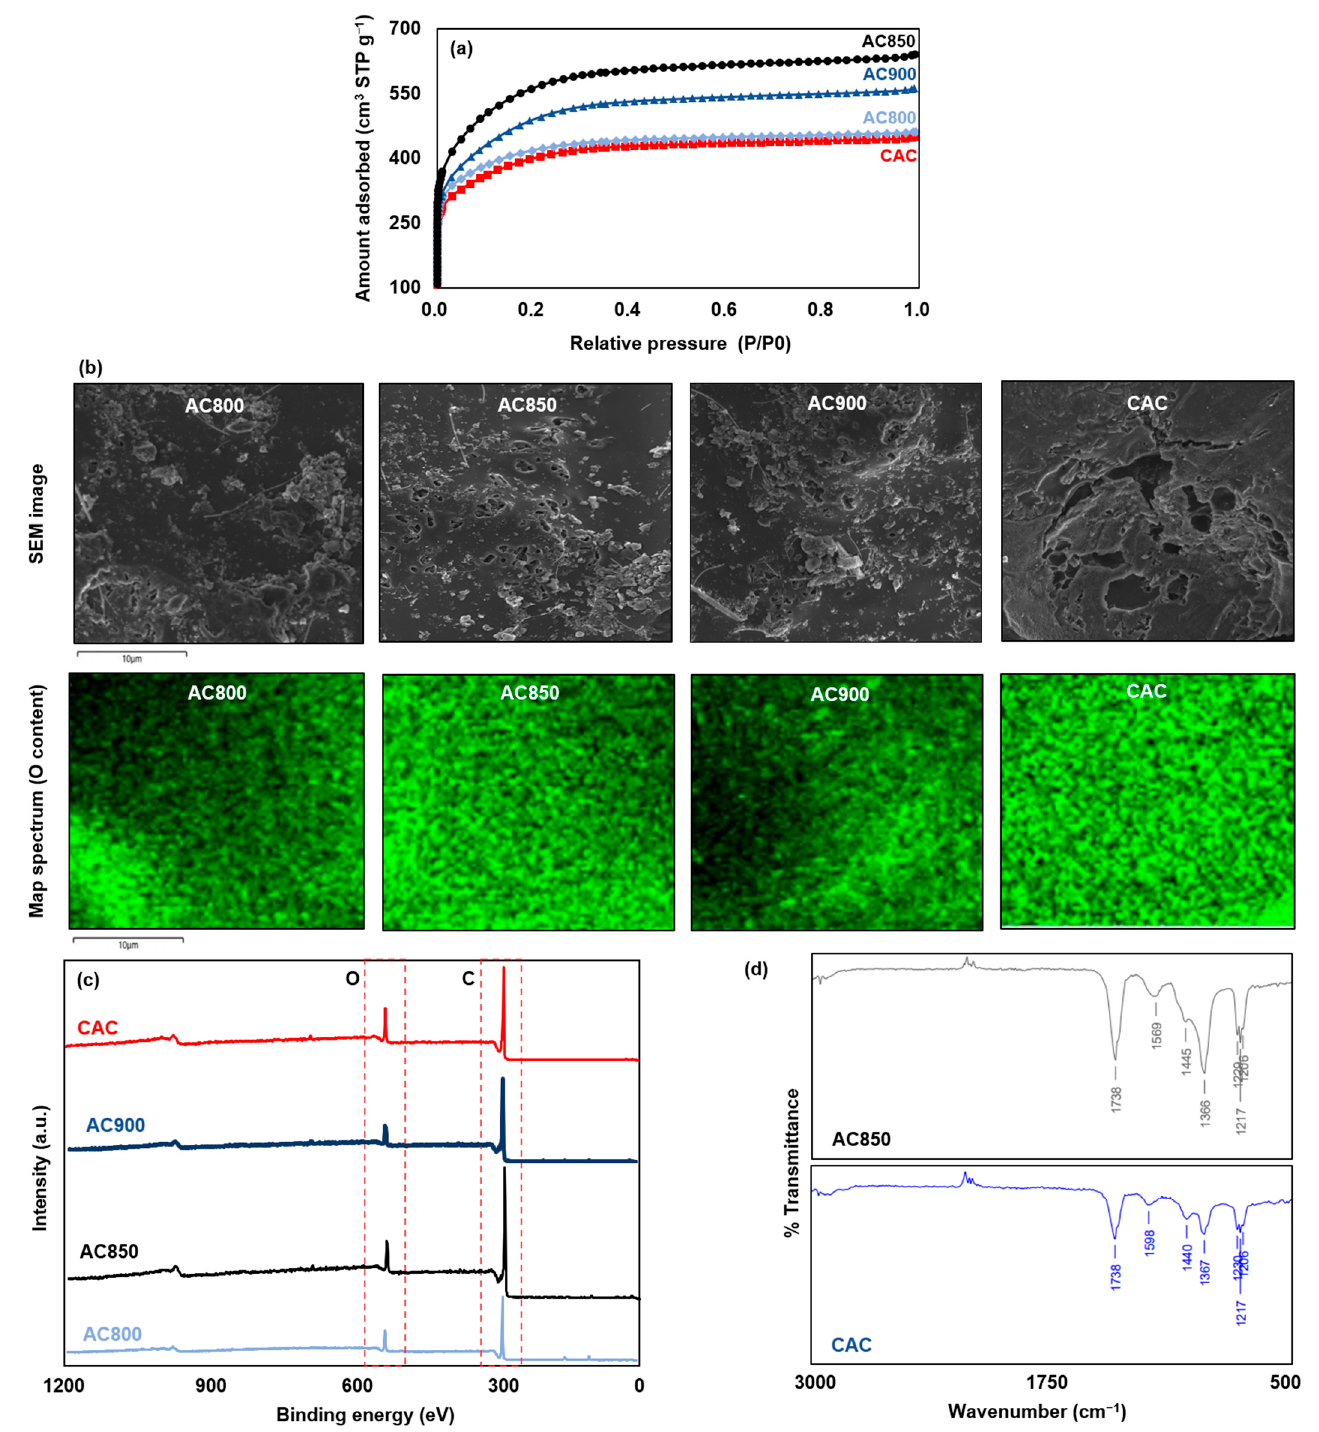
Figure 1. The N 2 adsorption–desorption characteristics of samples are shown in ( a ). SEM and the following O content is mapped in ( b ). XPS and FT-IR results of samples are shown in ( c , d ), respec- tively. Table 3. Visible FR-IR spectra of samples.